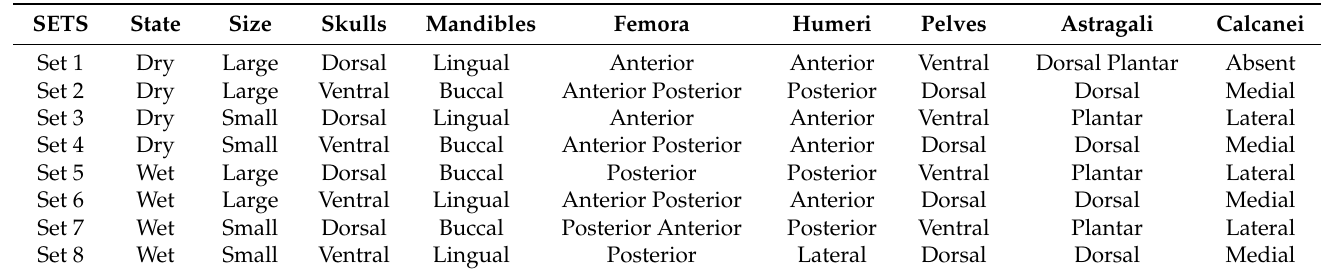
Table 1. The 60 skeletal elements used in the experiments and their position during compression from the 8 sets considered in the